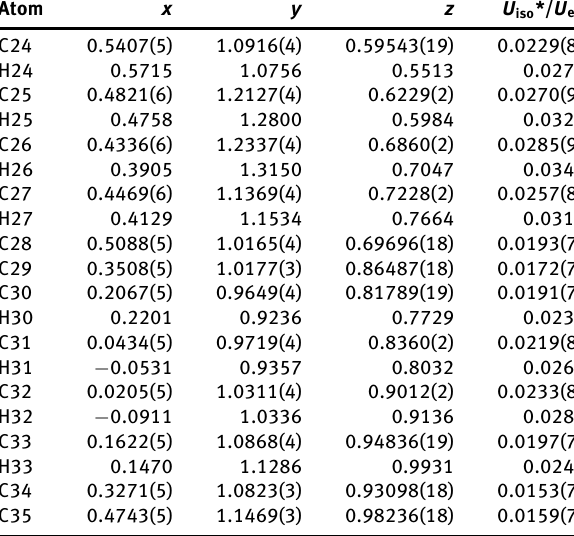
Table 2: Fractional atomic coordinates and isotropic or equivalent isotropic displacement parameters (Å 2